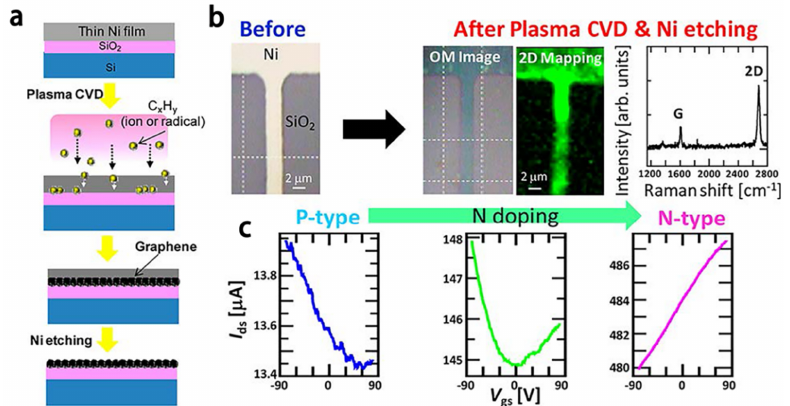
Figure 6. Plasma-enhanced growth. ( a ) Growth mechanism of graphene on the SiO 2 substrate; ( b ) Optical micrograph of graphene along with Raman spectrum; ( c ) Typical I ds -V gs curves for graphene grown at 950 °C, with NH 3 flow rates of 0 sccm, 5 sccm, and 15 sccm, respectively [40].